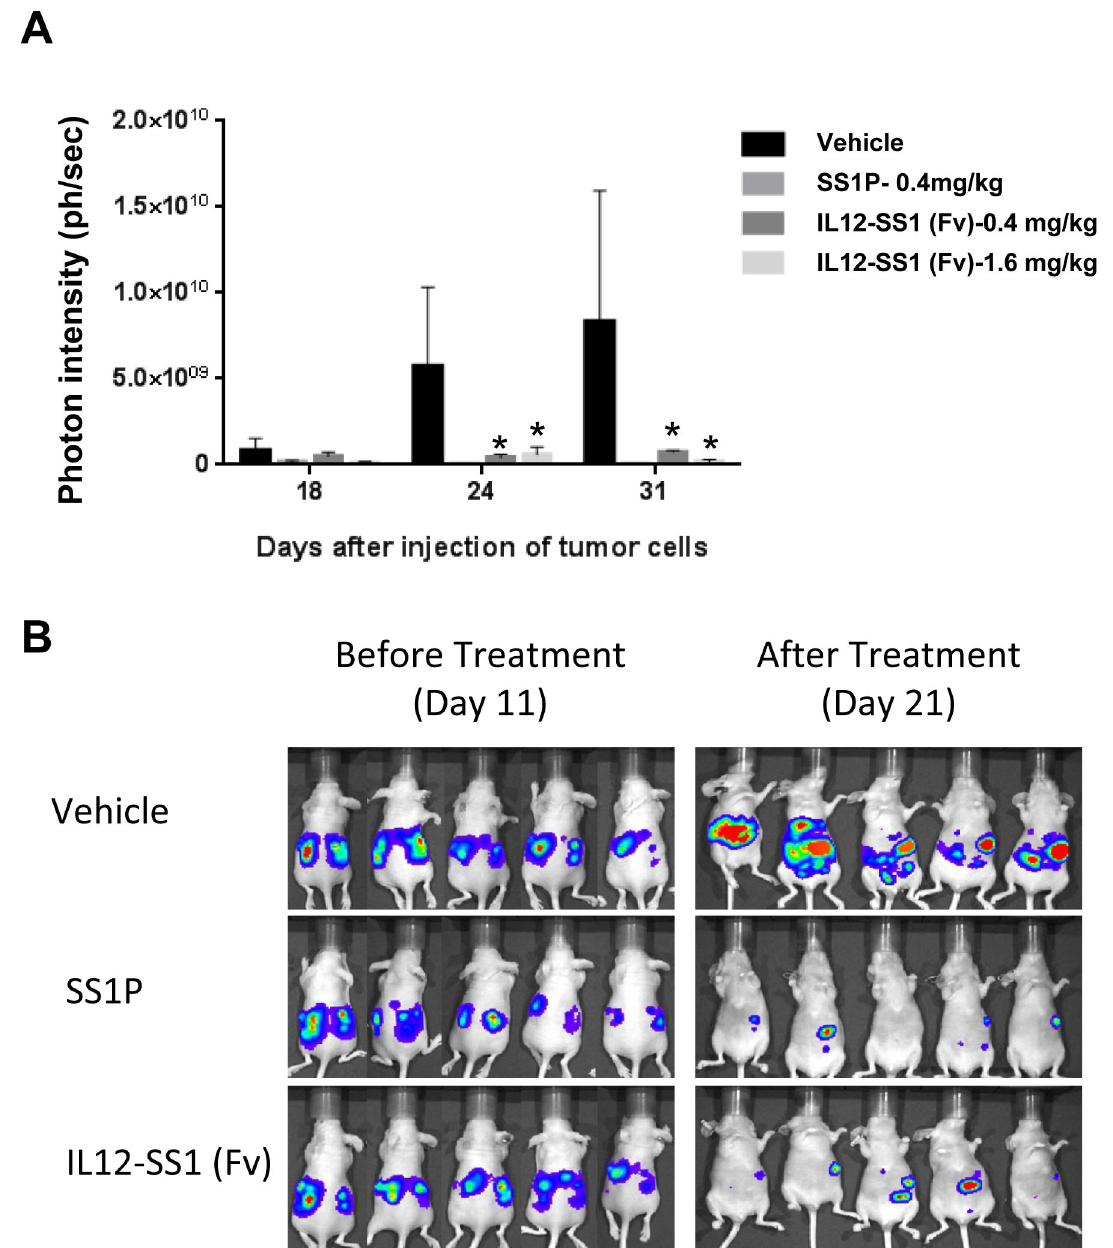
Figure 4. Tumor therapy studies with IL12-SS1 (Fv). (A) Treatment of 8-week old female athymic nude mice with IL12-SS1 (Fv) after intraperitoneal injection of LMB-H226-GL. SS1P (0.4 mg/kg), IL12-SS1 (Fv) (0.4 mg/kg), IL12-SS1 (Fv) (1.6 mg/kg), or vehicle (PBS) were intraperitoneally injected times at days 13, 15, 17, and 19 post-injection. Tumor growth was measured by bioluminescence photometry at day 18, 21, and 31. The photometry of the in vivo imaging was acquired using Living Image 3.1.0 software (Caliper Life Sciences). *Indicates the significant ( p < 0.05) difference between treatment and control (vehicle) by using the one-way ANOVA statistical test (GraphPad Prism 5.03). (B) Photograph of representative mice treated with IL12-SS1 (Fv), SS1P and vehicle